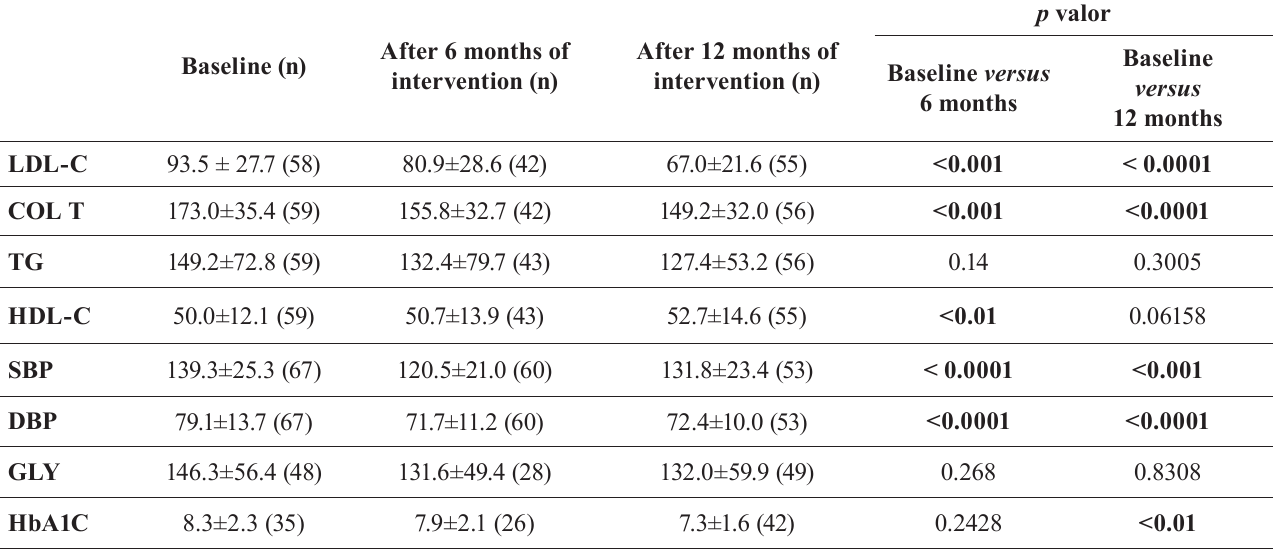
TABLE III – Clinical and laboratory parameters collected in three periods of pharmacotherapeutic follow-up in patients with dyslipidemia and comparative statistical analysis among the phases of the